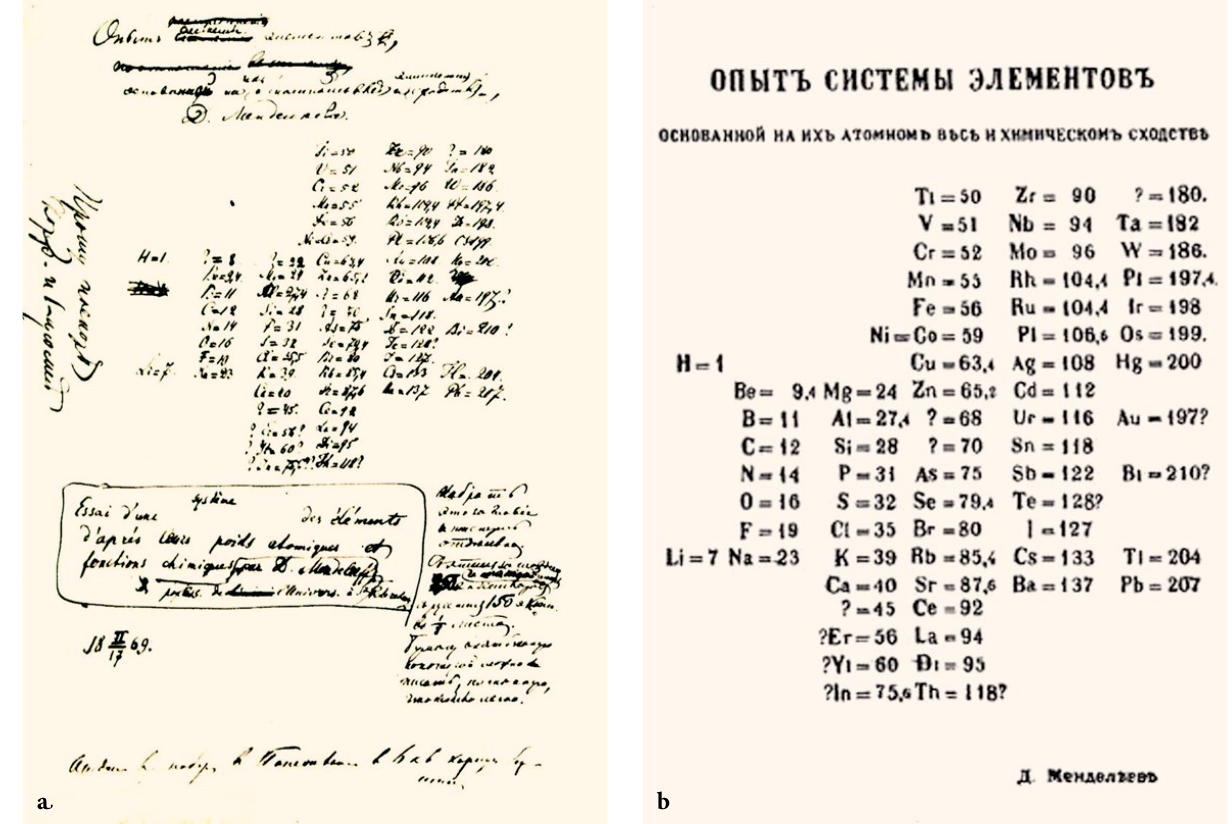
Figure 4. Mendeleev’s manuscript “Essay of the system of elements according to their atomic weights and chemical properties”, 17th of Feb- ruary 1869 (a). The first version of the Mendeleev’s Periodic system distributed before his report among the members of Russian Chemical Society and published in the beginning of the first two issues of “Fundamentals of Chemistry” in March 1869 (b) (permission of Museum and archives of Dmitri Mendeleev in St,